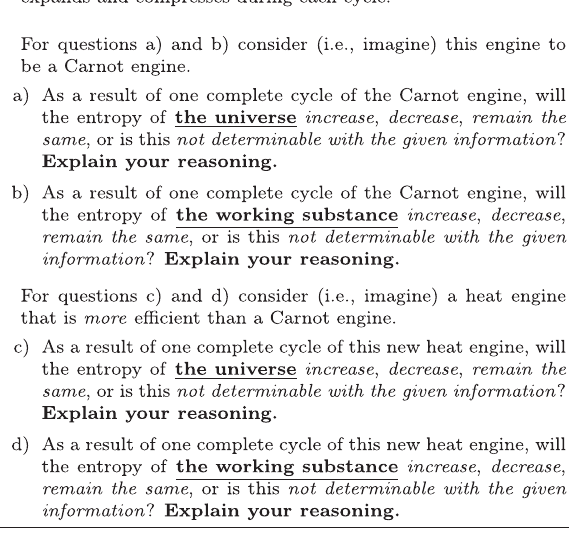
FIG. 1. The engine entropy question (EEQ). Administered after lecture instruction and again after tutorial